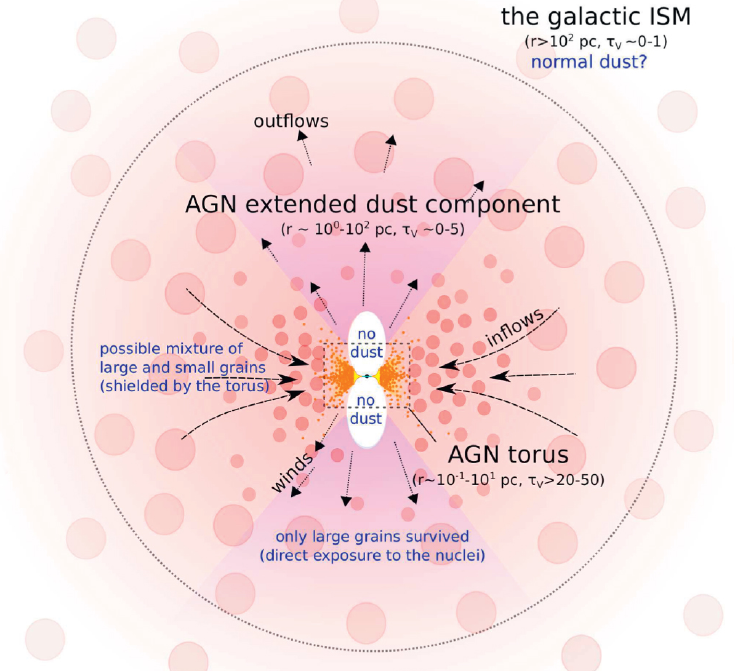
Figure 2. Cartoon illustration of the major IR-radiating components of a classical AGN [12]. The central engine and accretion disk are in the center, dwarfed in scale by the IR-emitting components. The circumnuclear “torus” is shown in cross-section and extends horizontally. We show it as a mixture of a clumpy and continuous distribution of gas and dust, heated by the emission of the accretion disk. The hottest dust, presumably of graphite, is at the inner edge of the torus, within which even carbon dust sublimates. Perpendicular and on either side of the torus, there are biconical outflows where the emission of the accretion disk can escape to excite emission lines. Dust in this region views the accretion disk directly. Close in, it is heated above its sublimation temperature and is destroyed, but further out, it can survive and is responsible for “polar dust emission” in the mid-IR. In all of these regions, the harsh environment imposed by the intense nuclear ultraviolet radiation [13], shocks [14], and sputtering due to hypersonic drift [15] probably modifies the distribution of dust grain sizes and hence the dust radiation